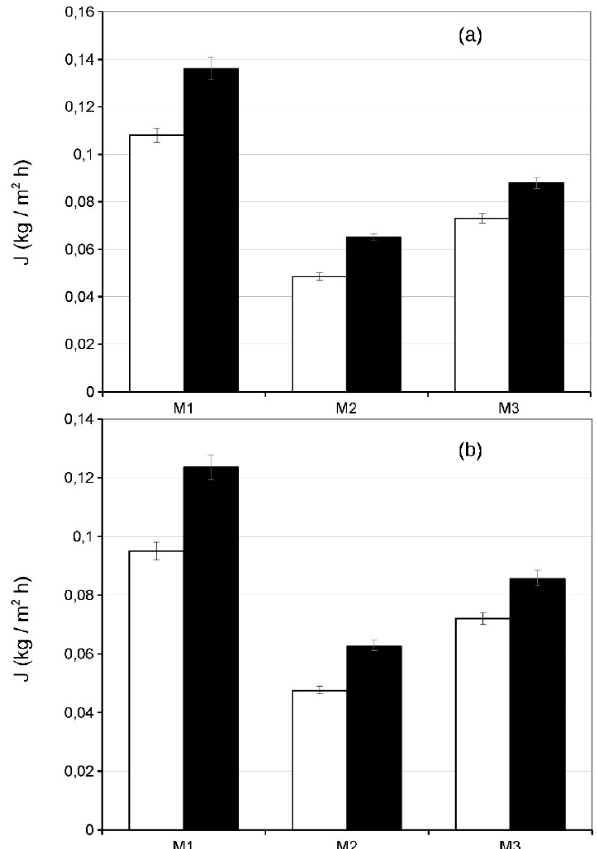
Figure 12. Water flux of 10 wt % of water in water+isopropanol (white box) and water + 1,4-dioxane (black box) feed mixtures vs. PVA (M1), PVA/Na + MMT-5(M2) and PVA/Na + MMT-10 (M3) mixed matrix membranes at 30 °C for ( a ) thermally crosslinked membranes and ( b ) glutaraldehyde crosslinked membranes [120].